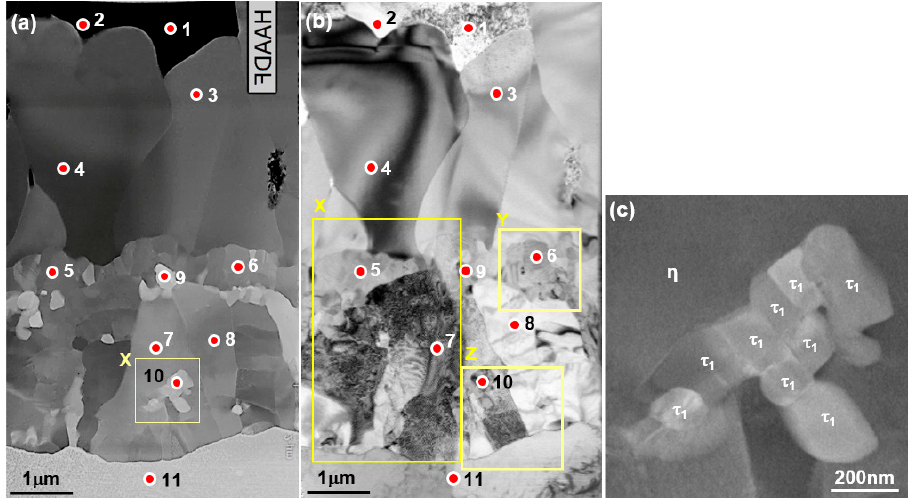
Figure 6. ( a ) HAADF image and ( b ) bright-field image of FE-TEM specimen for the area indicated by the rectangle in Figure 4b using FIB; and ( c ) an enlarged image of the area indicated by X in Figure 6a.